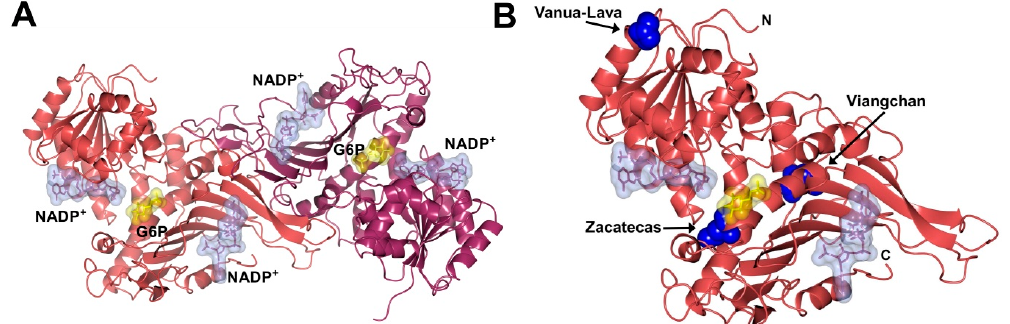
Figure 1. Crystallographic structure of the human glucose-6-phosphate dehydrogenase (G6PD) enzyme: ( A ) The human Wild Type (WT) structure of G6PD dimer (PDB entries 2BHL and 2BH9) showing the NADP + binding (ice blue molecular surface) at the structural and coenzyme sites and the G6P site (yellow molecular surface). The two monomers are shown in pale crimson and dark purple; ( B ) Zacatecas, Viangchan and Vanua-Lava mutants are shown as blue spheres in the human G6PD structure. The graphical representations were also constructed with CCP4mg version 2.10.4 [18].